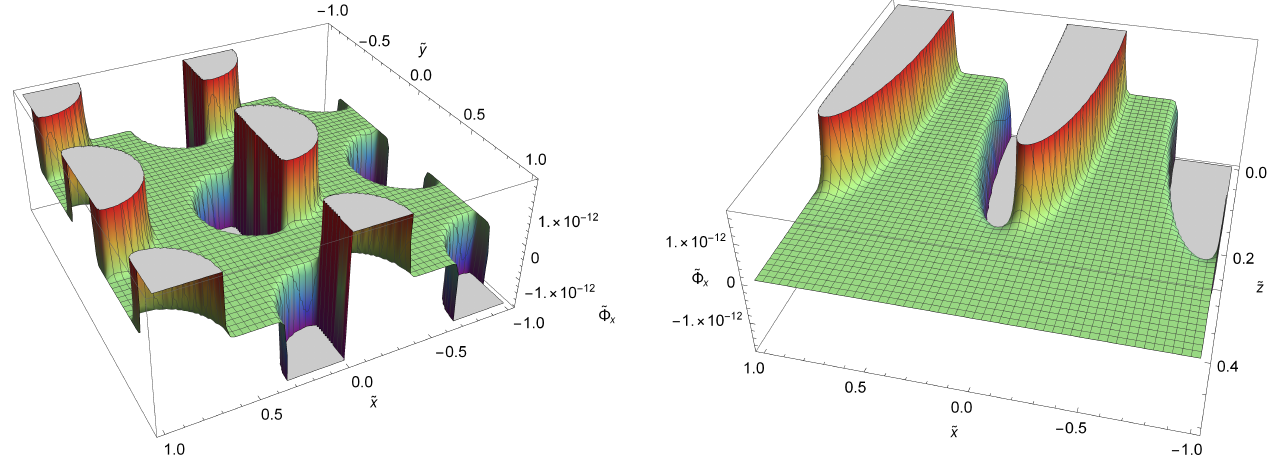
Figure 5. x -component of the rescaled force ˜ Φ x for ˜ λ eff = 0.01 for the sections z = 0 (left panel) and y = 0 (right panel).